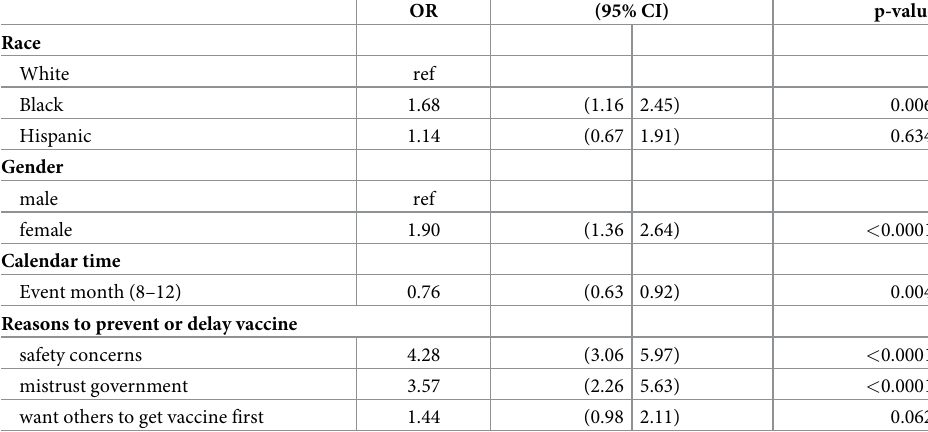
Table 4. Multivariable logistic regression–vaccine hesitancy ACCORD study, NC August-December